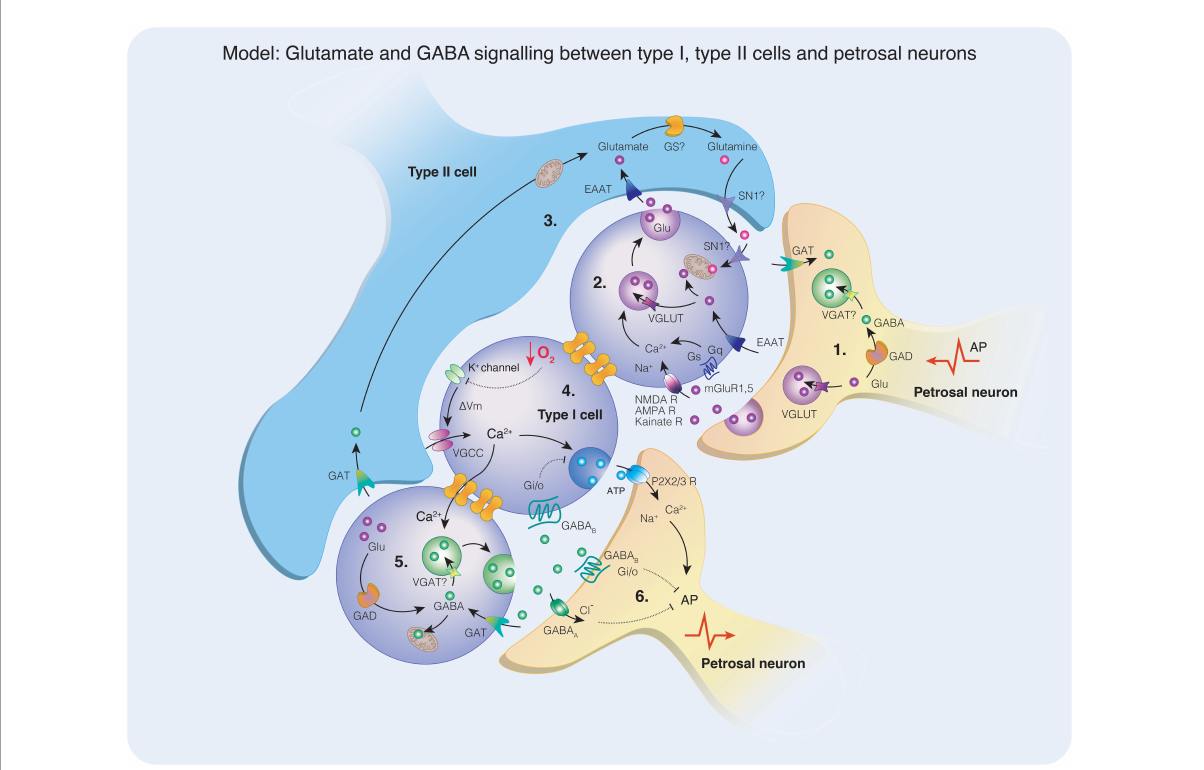
FIGURE5 A model depicting glutamate and gamma-aminobutyric acid (GABA) signaling mechanisms in the carotid body. (1) Glutamate is packaged into synaptic vesicles via the VGLUT transporter or may be converted to GABA via the activity of glutamic acid decarboxylase (GAD). The presence of vesicular GABA transporter (VGAT) required for the uptake of GABA into synaptic vesicles has not yet been identified in petrosal neurons. A retrograde action potential (AP) may stimulate the release of glutamate and / or GABA from petrosal neuron terminals into the synaptic space. (2) Glutamate acts on the ionotropic glutamate receptors (NMDA, AMPA, Kainate) or the metabotropic glutamate receptors (mGluR1, mGluR5) on type I cells. The activation of the ionotropic receptors does not appear to affect the acute response to hypoxia, however in